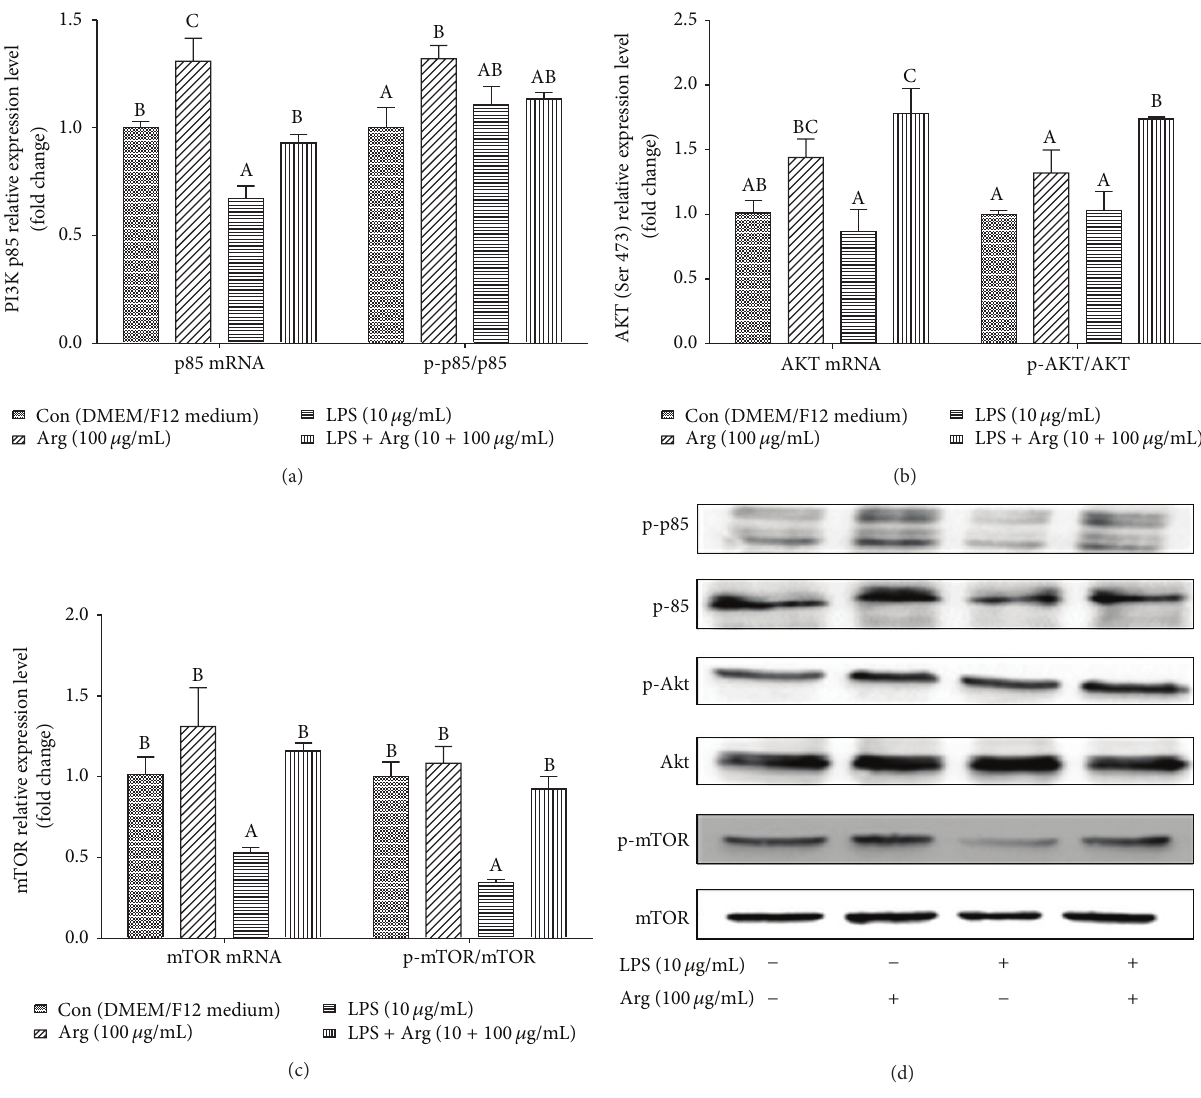
Figure 4: Effect of Arg on the mRNA expression and phosphorylation levels of PI3K/AKT/mTOR signaling pathway in LPS-treated BMECs. Pure 2nd generation BMECs were starved for 16h and then cultured for 12h in DMEM/F12 medium containing 0 or 10 𝜇 g/mL LPS and 0 or 100 𝜇 g/mL Arg. The mRNA levels of PI3K, AKT, and mTOR were analyzed using qPCR. Protein expression and its phosphorylation level were analyzed using western bolt. 𝛽 -Actin was used as an internal reference. Data shown are mean ± SEM of three independent experiments. Means with different letters (A, B, or C) are significantly different ( 𝑃 < 0.05 ) from each other.